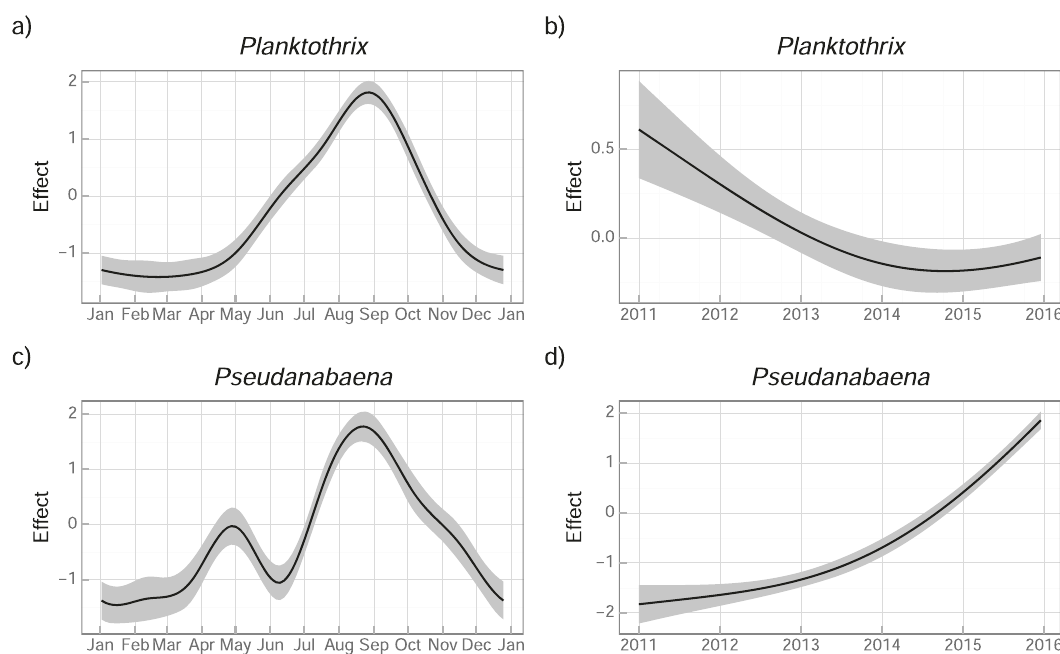
Fig. 2 Temporal distribution of two fi lamentous cyanobacteria (log 10 (1 + N), unit: cells L − 1 ) from 2011 to 2015 separated into seasonal and long-term trends by generalized additive models. a Seasonal variation of Planktothrix . b Inter-annual dynamics of Planktothrix from 2011 to 2015. c Seasonal variations of Pseudanabaena . d Inter-annual dynamics of Pseudanabaena from 2011 to 2015. Shaded areas represent 95% con fi dence